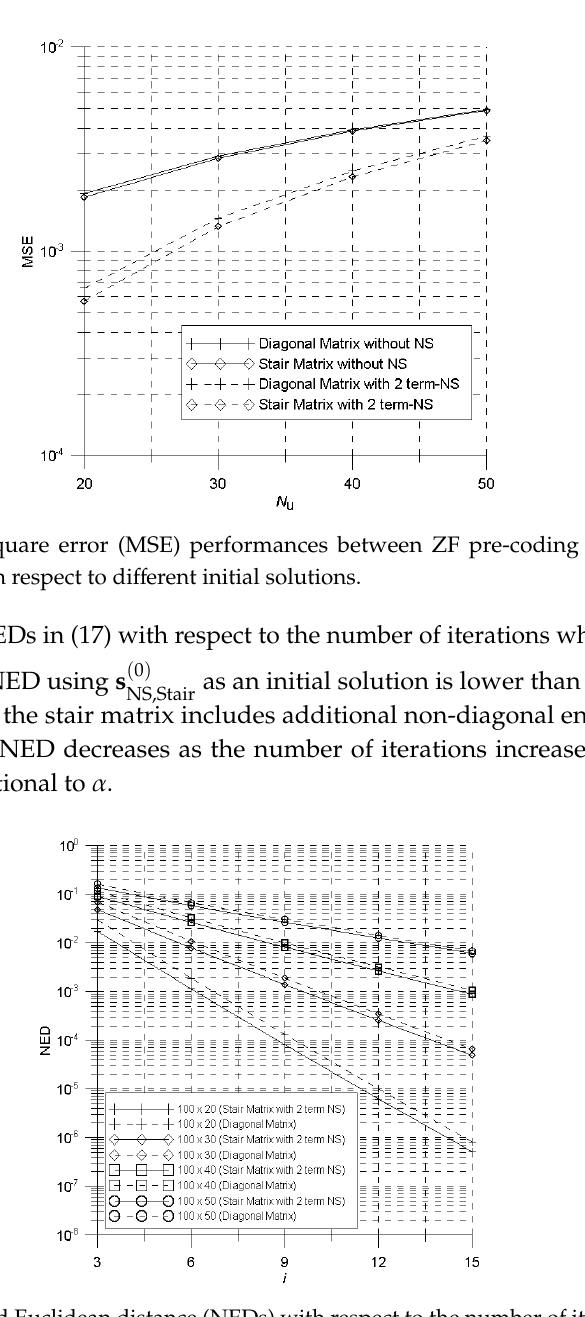
( 0 ) ( 0 ) and s NS,Stair Diag